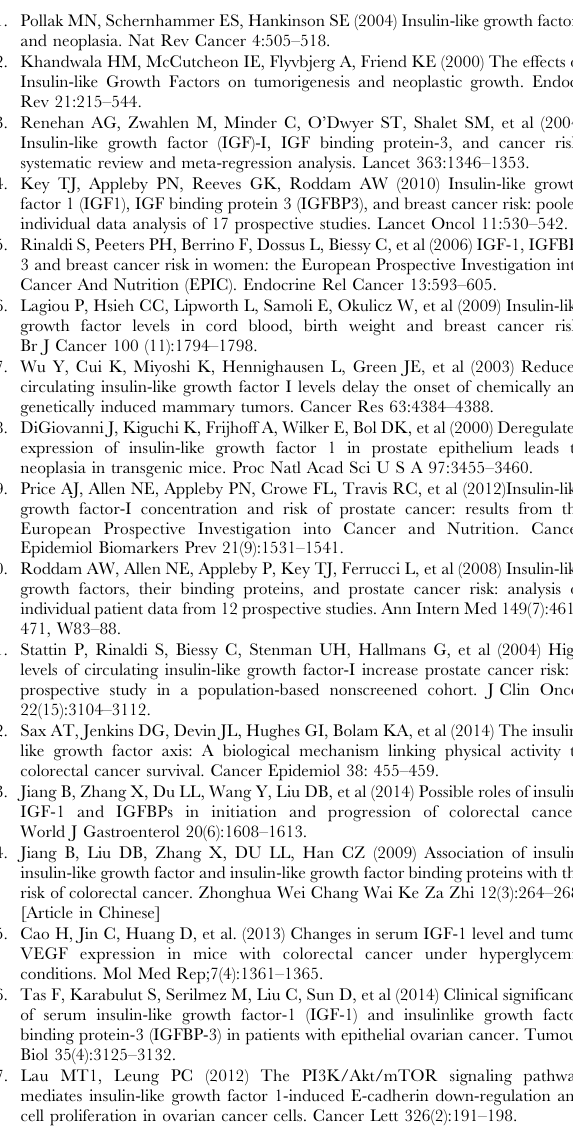
Table S1 Associations between general demographic, reproduc- tive factors and circulating IGF components